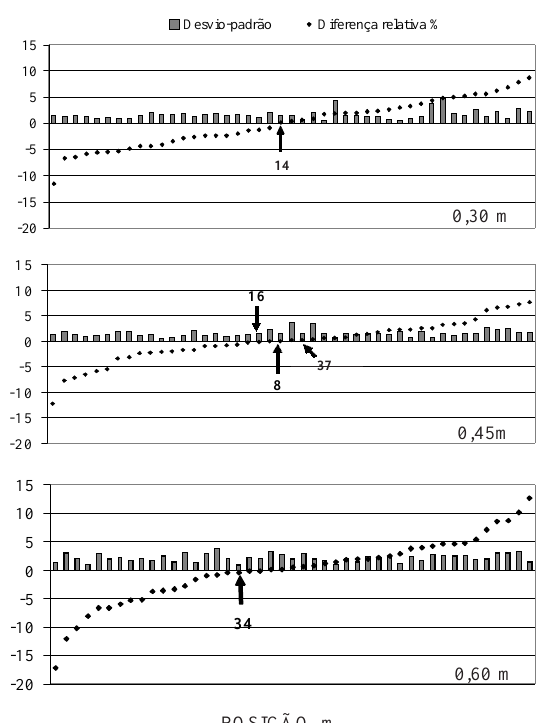
Figura 4. Diferença relativa média intertemporal e desvio-padrão para o teor de água no solo (m m -3 ), em três profundidades, segundo uma transeção de 50 pontos espaçados de um metro. Valores em destaque indicam os pontos que devem ser adotados para medidas representativas da média de umidade no solo.